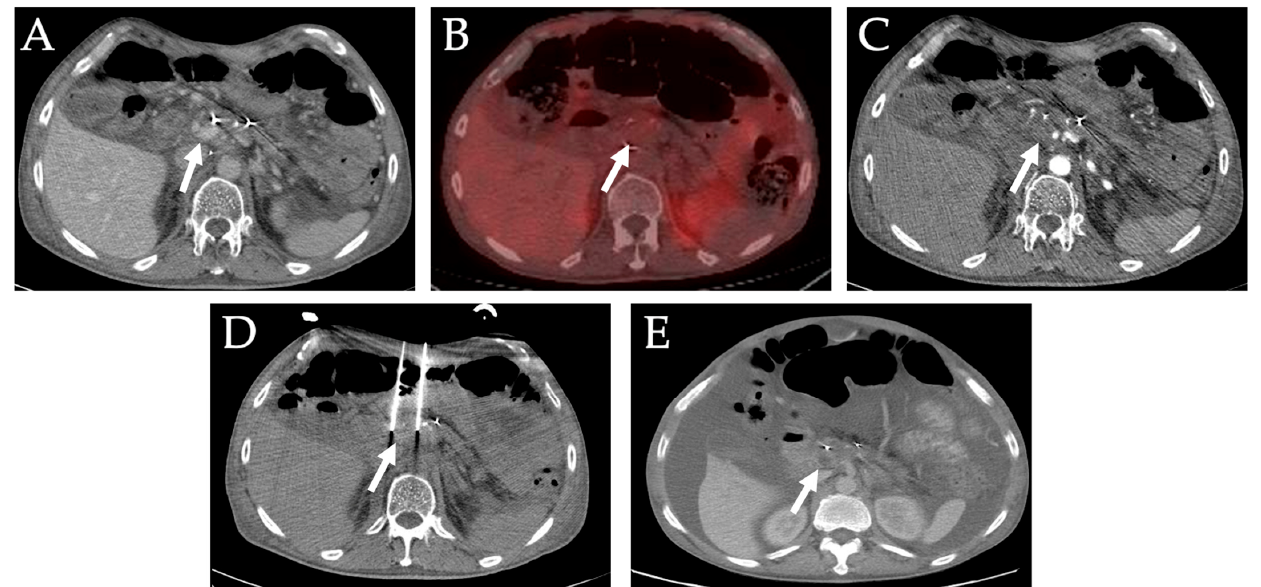
Figure 11. Irreversible electroporation of locally advanced pancreatic mass . A 57-year-old male with a history of pancreatic cancer presented with nonspecific epigastric pain. He was found to have locally advanced pancreatic head tumor (white arrow). He underwent chemotherapy and radiation and follow up CT and PET images ( A – C ) showed persistent locally advanced pancreatic head tumor. ( D ) He subsequently underwent IRE. ( E ). One-month follow up CT scan shows no residual disease.